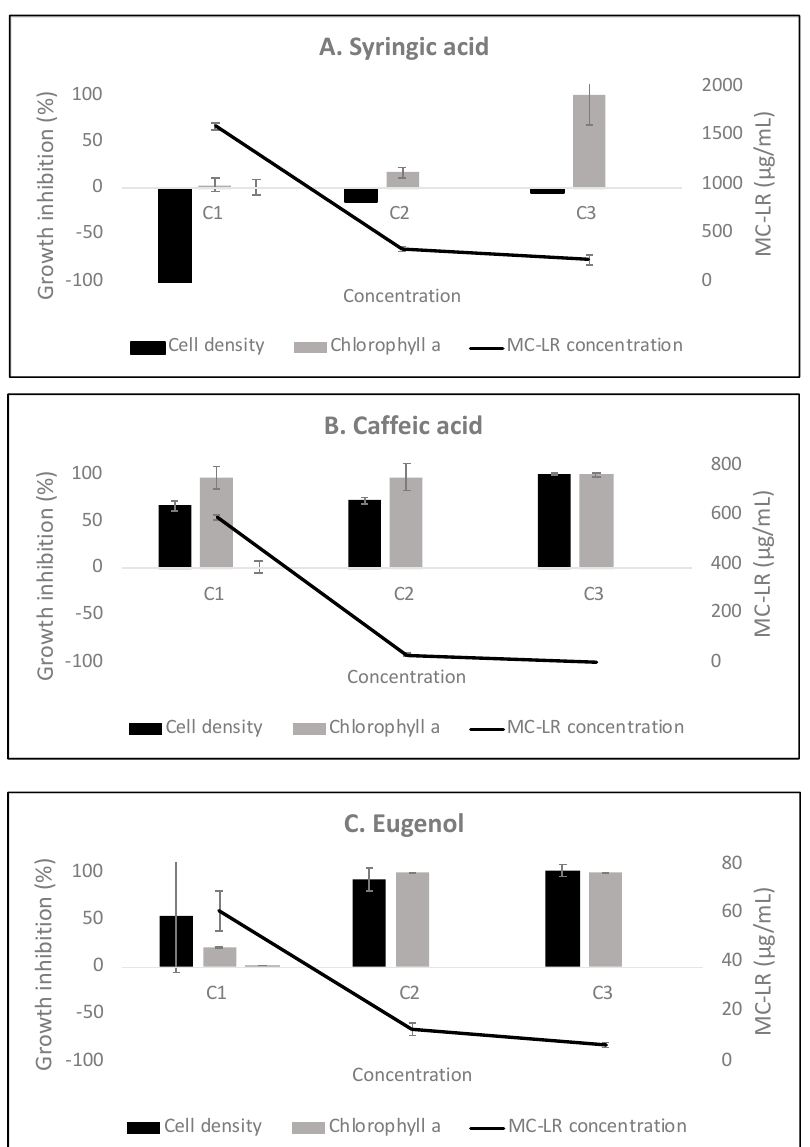
Figure 5. The effect of syringic acid ( A ), caffeic acid ( B ), and eugenol ( C ) on the concentration of microcystin-LR (MC-LR) in cultures of M. aeruginosa Kützing. The concentrations assayed were 100 mg/L (C3), 50 mg/L (C2), and 25 mg/L (C1).